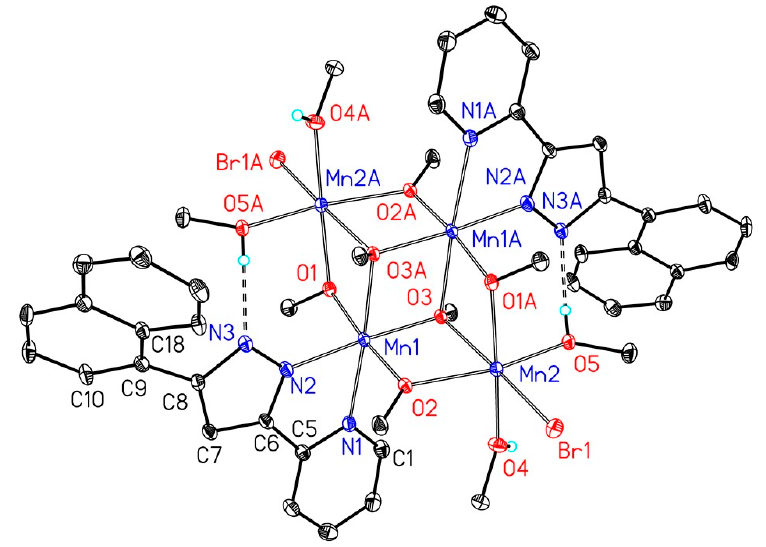
Figure 4. Molecular structure and numbering scheme of [(MeOH) 4 Mn 4 (Br) 2 (OMe) 6 (2-PyPz Naph ) 2 ] ( 3b ). The ellipsoids represent a probability of 30%, H atoms are omitted for the sake of clarity with the exception of those of the ligated methanol molecules.